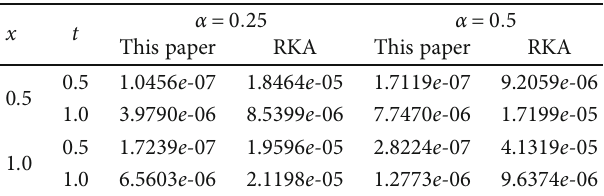
Table 1: Maximum pointwise errors for the new method and the RKA